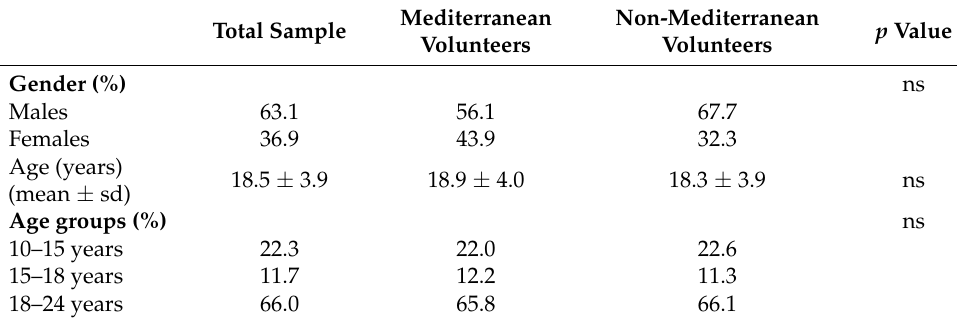
Table 2. Study sample characteristics by geographical area of